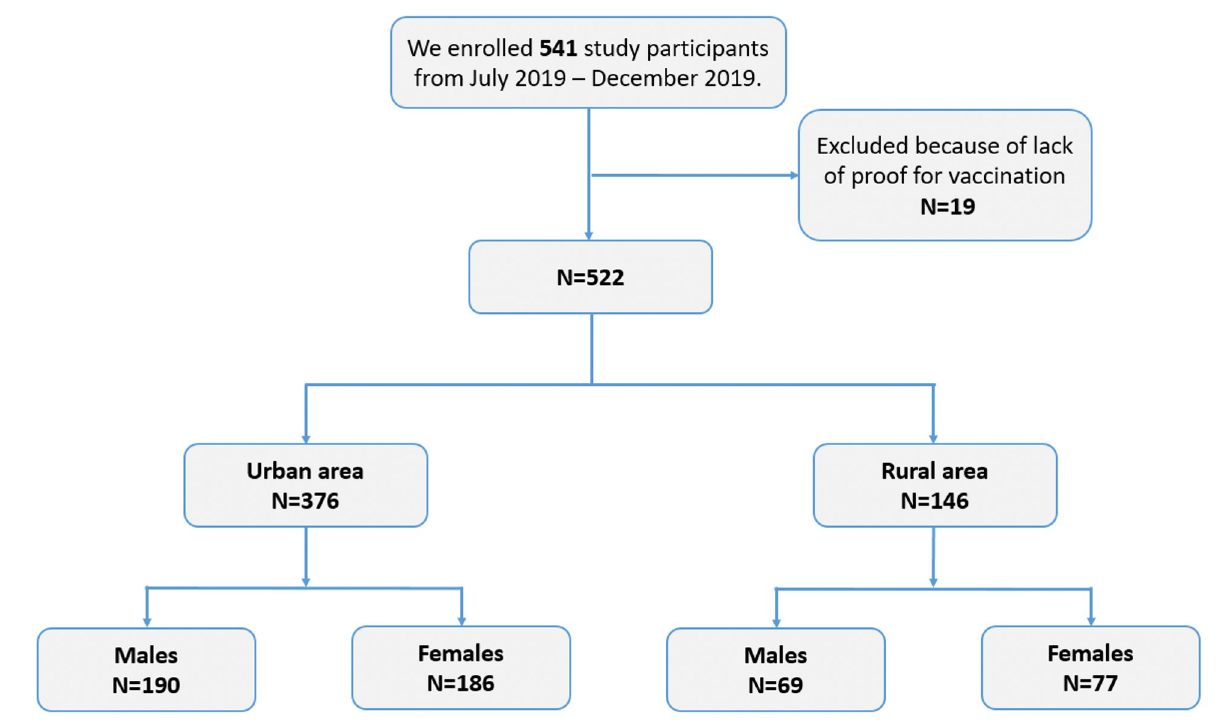
Fig 1. Study design flowchart. Consort diagram showing the inclusion of children in this study.